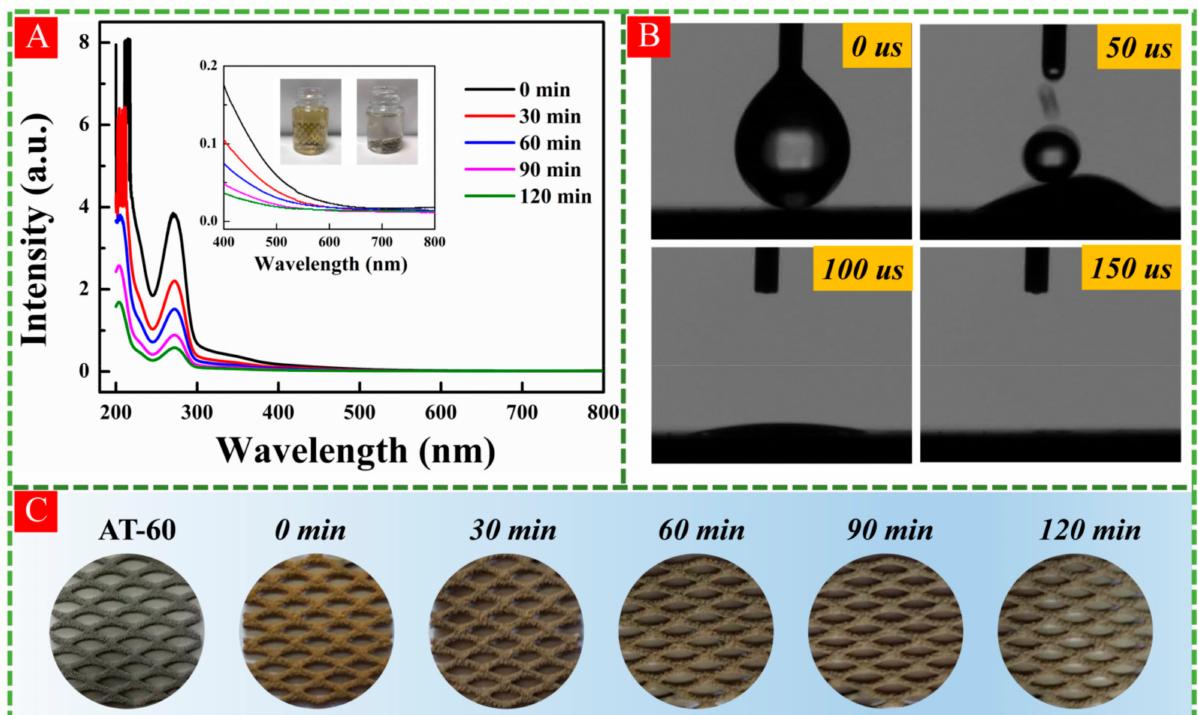
Figure 9. ( A ) Photocatalytic degradation curves of black tea water pollutants with 2 pieces AT-60 under visible-light irradiation, and the photographs of variations in black tea water as shown in inset. ( B ) The examinations of surface hydrophilic performance, and ( C ) the self-cleaning surface with degradation of absorbed organics in black tea water using